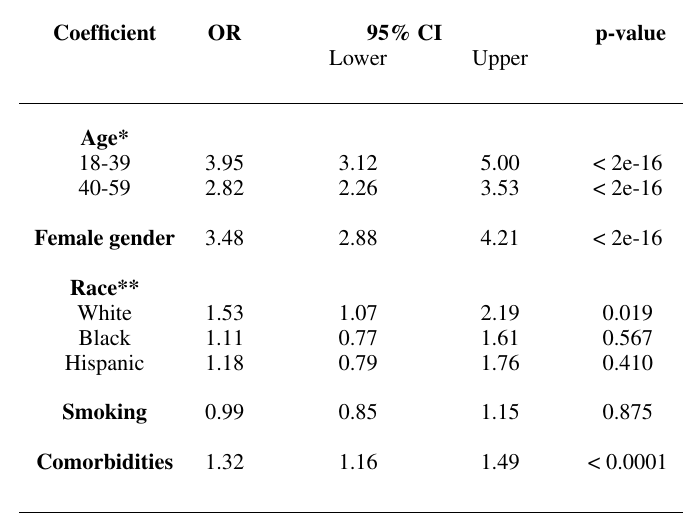
Table 3. Predictors of Migraine headache among MS